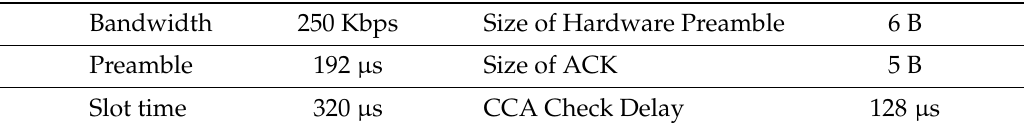
Table 1. Simulation radio